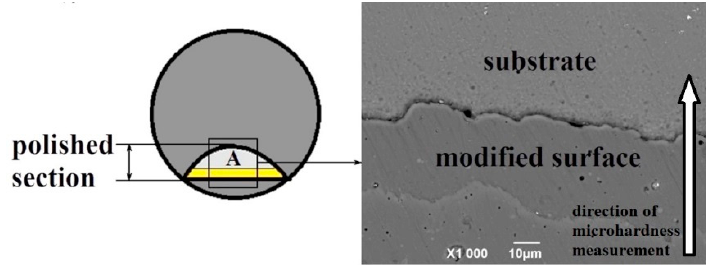
Figure 2. Scheme of microhardness measurement over the sample depth.